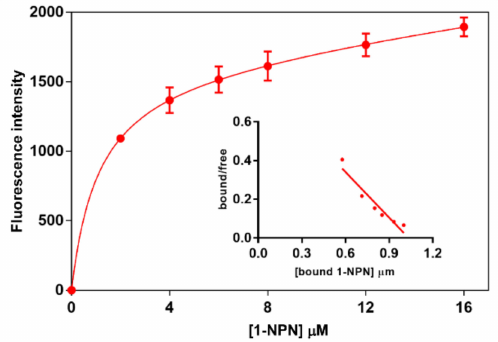
Figure 6. Affinity of 1-NPN to the recombinant protein PsauGOBP1. A 2 mM solution of the protein in Tris was titrated with a 1 mM solution of 1-NPN in methanol to final concentrations of 2–16 µ M. Analysis of the means of three replicates by Prism software indicated the presence of a single binding site with a dissociation constant of 1.9 µ